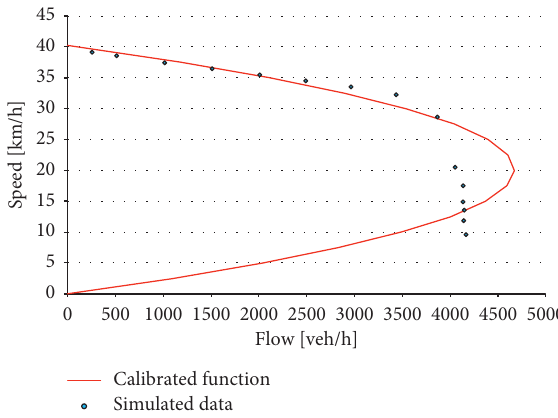
Figure 9: Calibrated function f � f ( v ) in the case of network configuration 3 for the integrated solution.